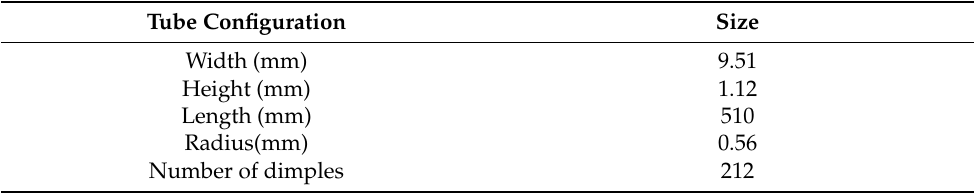
Table 1. Main parameters of the micro-tube with